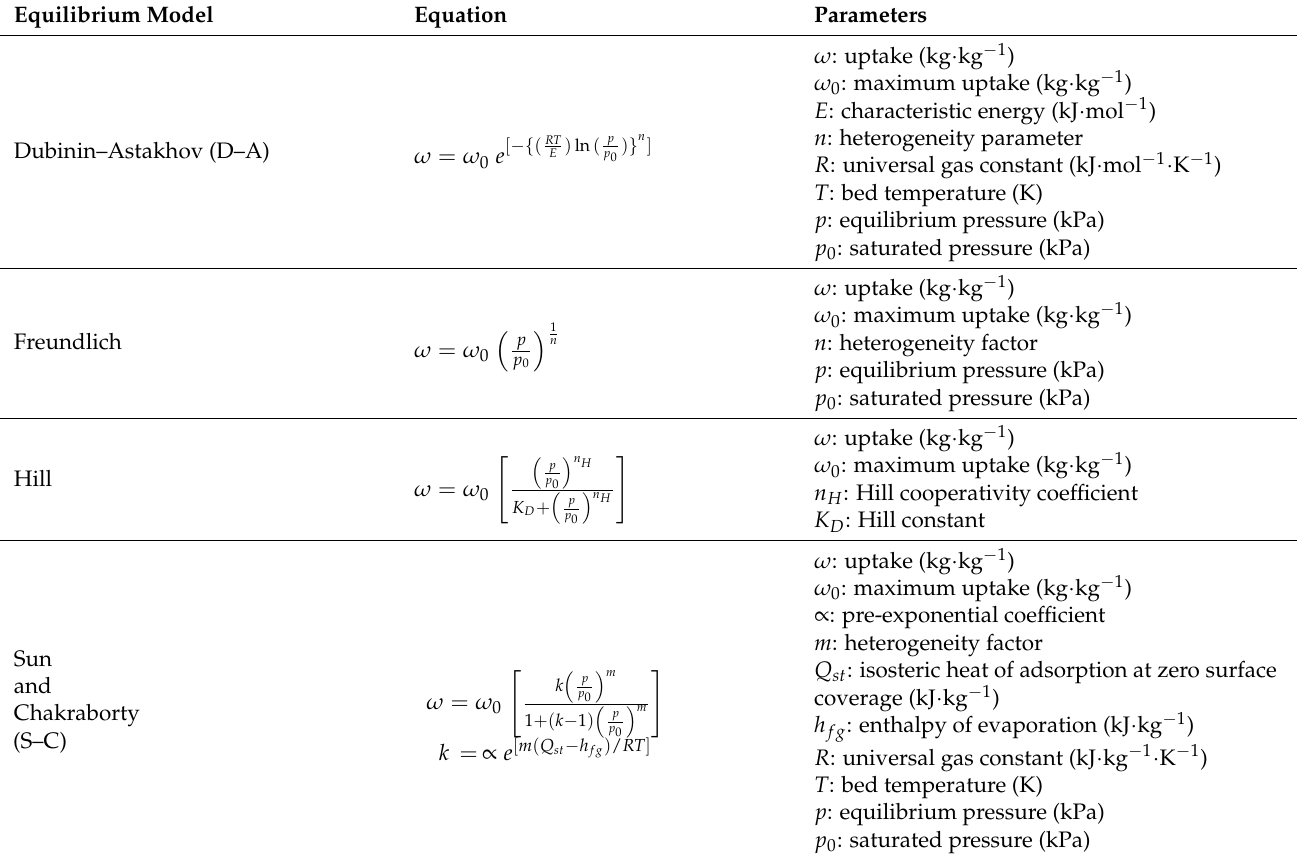
Table 1. Adsorption isotherm equations for different